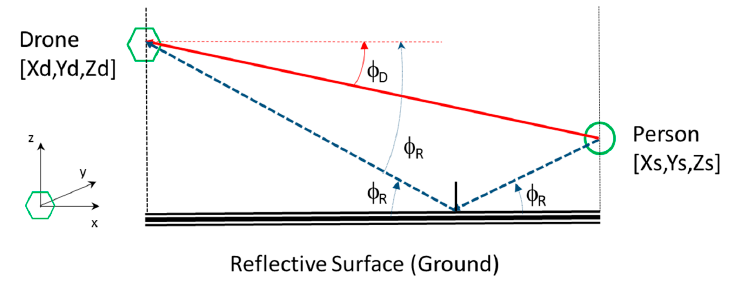
Figure 6. Angles of arrival in elevation.